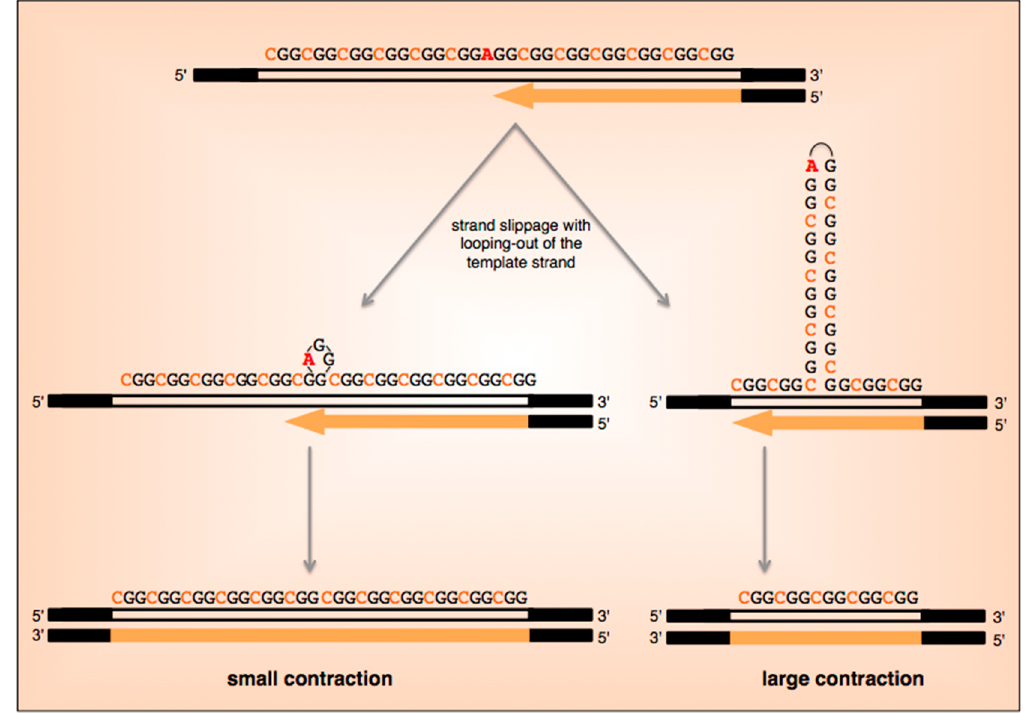
Figure 4. Model for repeat contraction and loss of AGG interruptions. During chromosomal replication or repair synthesis, strand ‐ slippage within the repeat can result in a loop ‐ out forming either on the nascent strand (not illustrated) or the template strand. A loop ‐ out on the slipped nascent strand is thought to result in expansions by causing repriming to occur more 3 ′ on the template, while a loop ‐ out on the template strand results in repriming more 5 ′ on the template leading to contractions. In a FX PM mouse model, a bimodal distribution of contraction sizes is seen with some alleles having lost 1–2 repeats and other having lost >7 [48]. Small contractions may result from the looping out of 1–2 repeats while larger contractions arise from the formation of larger loop ‐ outs that may be stabilized by hydrogen bonding. If the template ‐ strand loop ‐ out contains the AGG interruption, then the interruption would be lost.